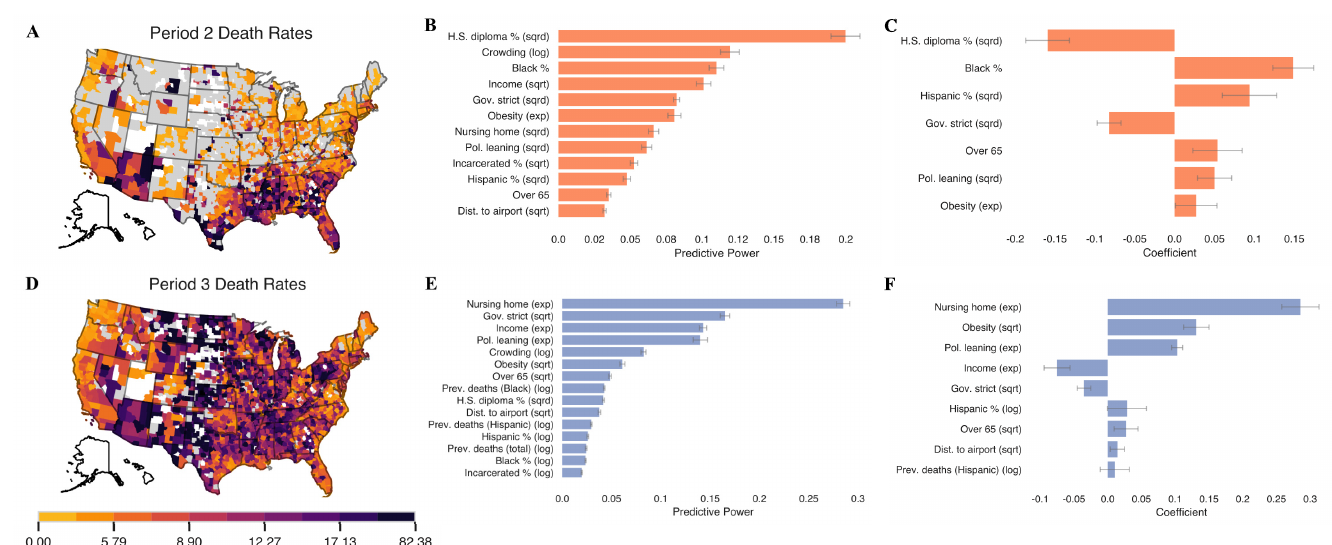
Fig 5. A summary of model results in periods 2 and 3. (A, D) distributions of death rates in period 2 and 3, respectively. (B-C) feature importance and coefficients for the random forest and LASSO model, respectively, when predicting period 2 death rates. (E-F) the same plots for period 3 death rates. Any variables that have a coefficient of zero in the LASSO model are excluded from the plot. Error bars indicate one standard deviation (random forest models) and one standard error (LASSO models). Counties are plotted using the U.S. Census Bureau’s 2019 shapefiles [24].